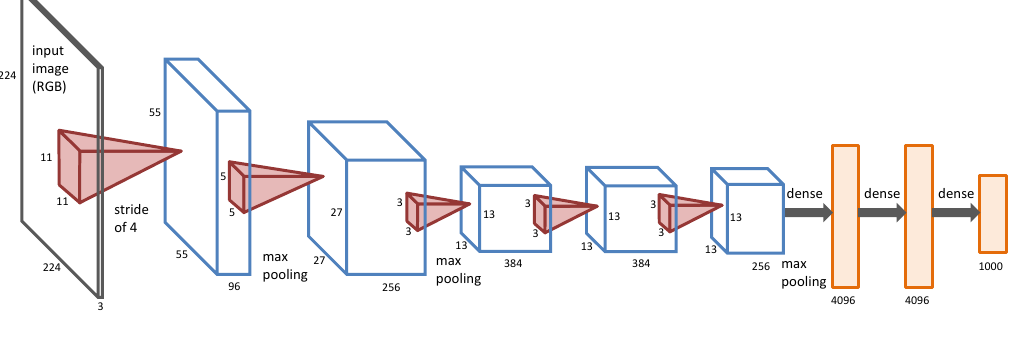
Figure 2. An illustration of the architecture of the DCNNs proposed by Alex et al.